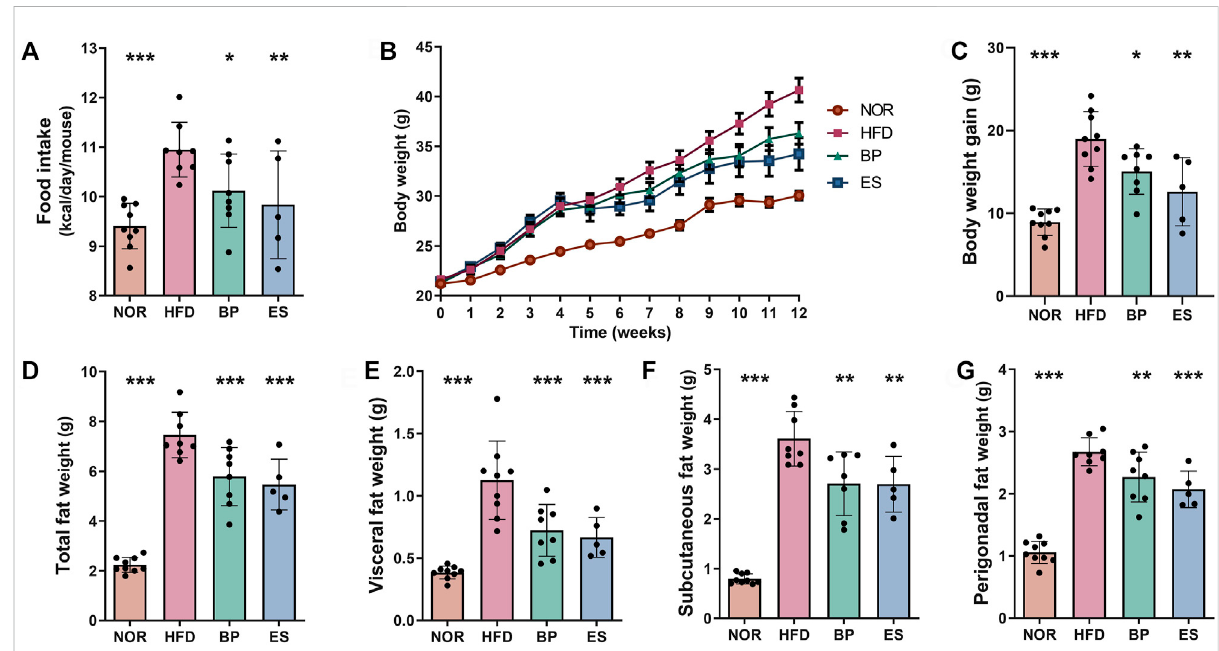
FIGURE 1 Effectofanti-obesitydrugsonweightandfataccumulation inahigh-fatdiet(HFD)-inducedobesemodelaftertreatmentfor8 weeks. (A) Food intake. (B) Bodyweight. (C) Bodyweightgain. (D) Totalfatweight. (E) Visceralfatweight. (F) Subcutaneousfatweight. (G) Perigonadalfatweight.Data are expressed as the mean ± SEM. Statistical signi fi cance was assessed using one-way ANOVA. * p < 0.05, ** p < 0.01, *** p < 0.001, vs. HFD. NOR, control group; BP, bupropion; ES, Ephedra sinica